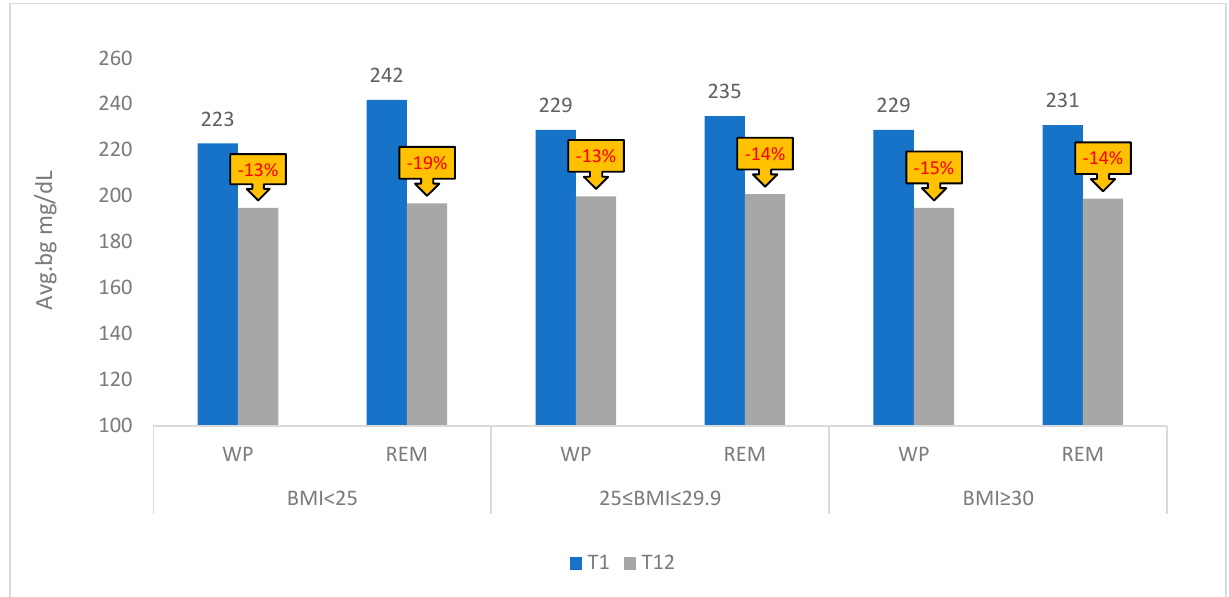
Figure 2. Average blood glucose levels (mg/dL) presentation by the WP and REM groups and BMI levels. WP, White persons; REM, people from racial and ethnic minority groups; Avg.bg, the average blood glucose levels; races/ethnicities as WP and REM (Latino, Black, and Asian); BMI groups < 25 kg/m 2 ; 25–29.9 kg/m 2 ; ≥ 30 kg/m 2 ; The change in average blood glucose from T 1 to T 12 is presented as a percentage.